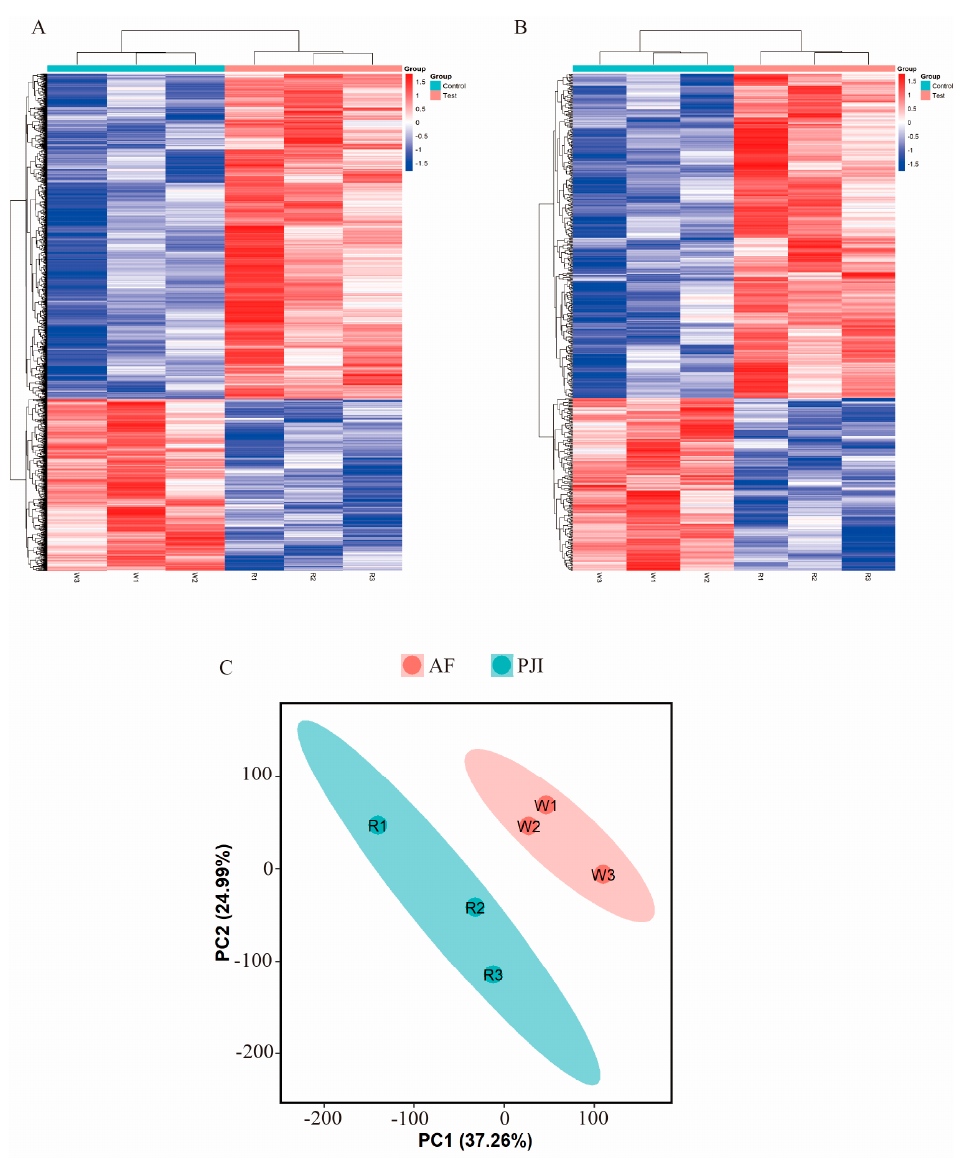
Figure 3. Hierarchical clustering analysis of differential m6A-modified mRNAs ( A ) and lncRNAs ( B ). Principal component analysis of di ff erential m6A-modi fi ed mRNAs ( C ).